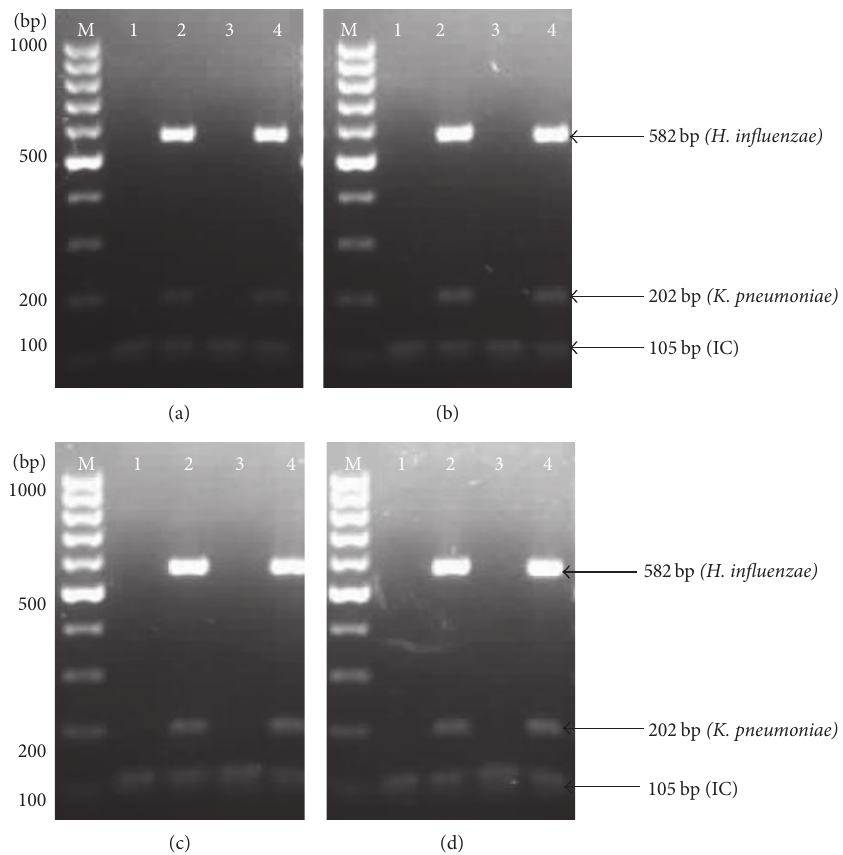
Figure 3: Effect of different concentrations of Taq DNA polymerase on the performance of thermostabilized multiplex PCR. (a) 100% Taq DNA polymerase. (b) 150% Taq DNA polymerase. (c) 200% Taq DNA polymerase. (d) 250% Taq DNA polymerase. Lane M: 100 bp DNA ladder (Fermentas, USA); Lane 1: negative control before lyophilization (IC); Lane 2: positive control before lyophilization (IC + K. pneumoniae + H. influenzae ); Lane 3: negative control after lyophilization (IC); Lane 4: positive control after lyophilization (IC + K. pneumoniae + H. influenzae ).